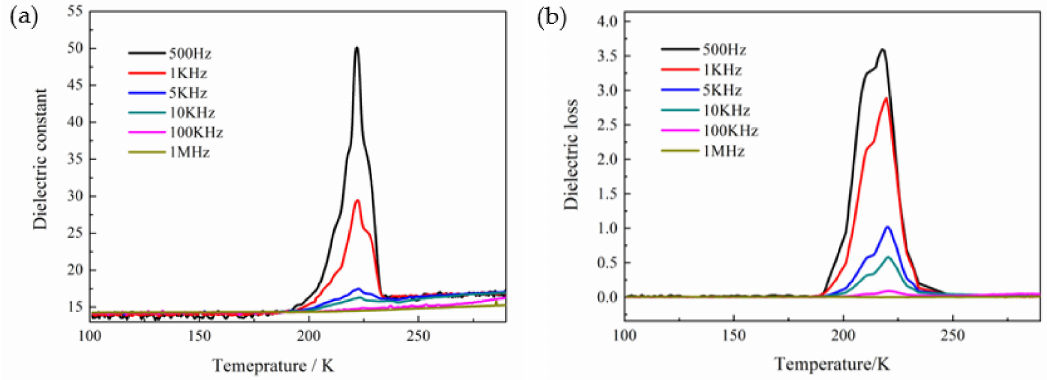
Figure 6. ( a ) Real part ( ε (cid:48) ) and ( b ) imaginary ( ε (cid:48) ’) of permittivity on the dielectric response of 1 measured at 500 Hz–1 MHz obtained on heating and